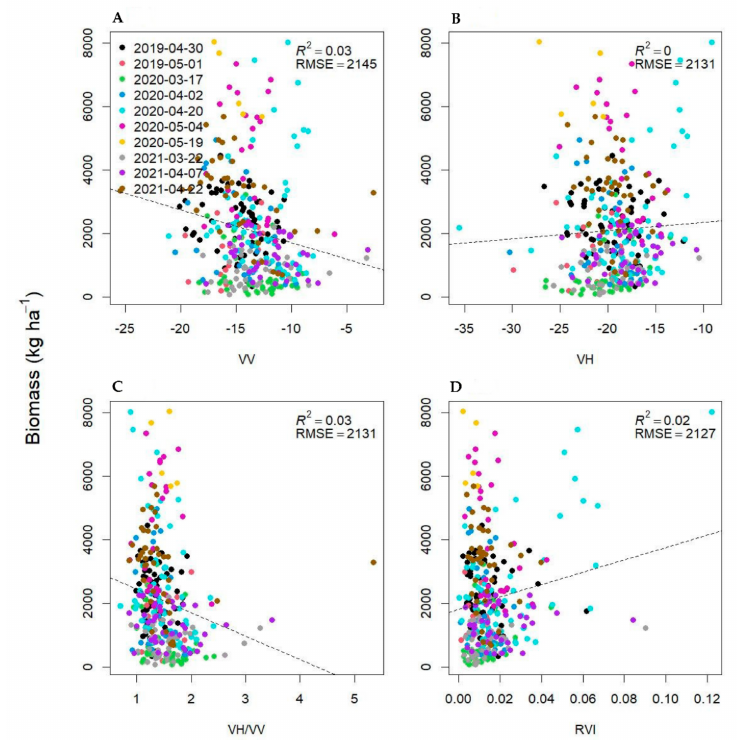
Figure A3. Cover crop biomass as a function of synthetic aperture radar linear backscatter intensities— vertical-vertical (VV; ( A )), vertical horizontal (VH; ( B )), VV/VH ratio ( C ) and the radar vegetation index (RVI; ( D )).